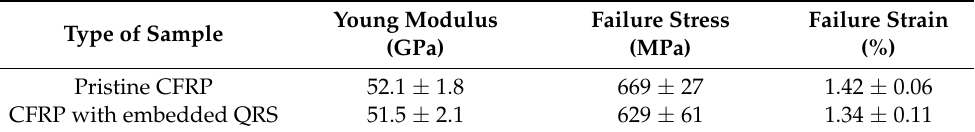
Figure 3. ( a ) Static three-point bending mechanical behavior of a CFRP composite with and without embedded QRS displaying equivalent behavior. Fracture profile under the central span ( b ) with and ( c ) without embedded QRS. The red line represents the fracture path. Table 1. Mechanical properties of a CFRP composite (0/90 ◦ ) with and without embedded QRS in static three-point bending, according to standard NF EN ISO